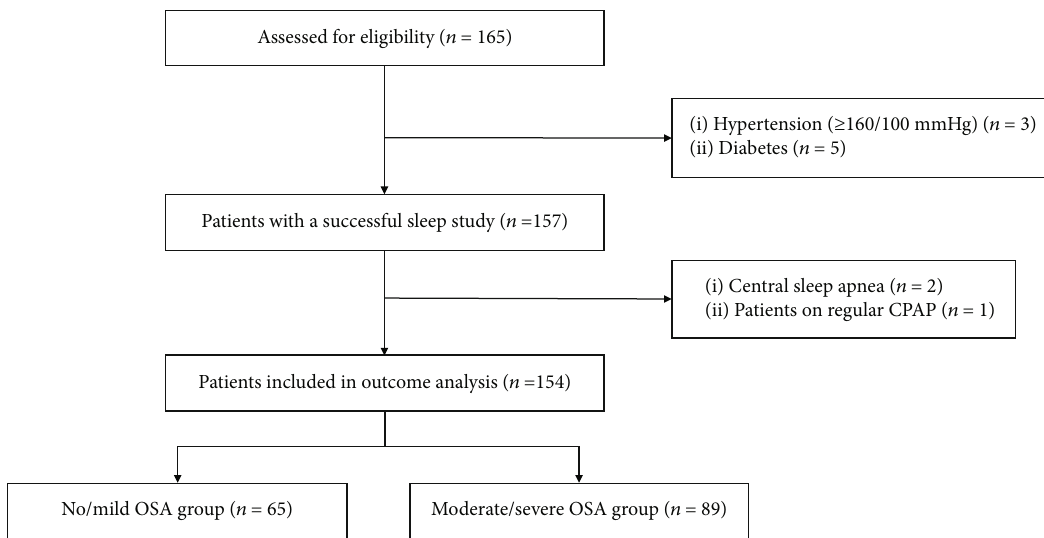
Figure 1: Study fl owchart. CPAP: continuous positive airway pressure; OSA: obstructive sleep